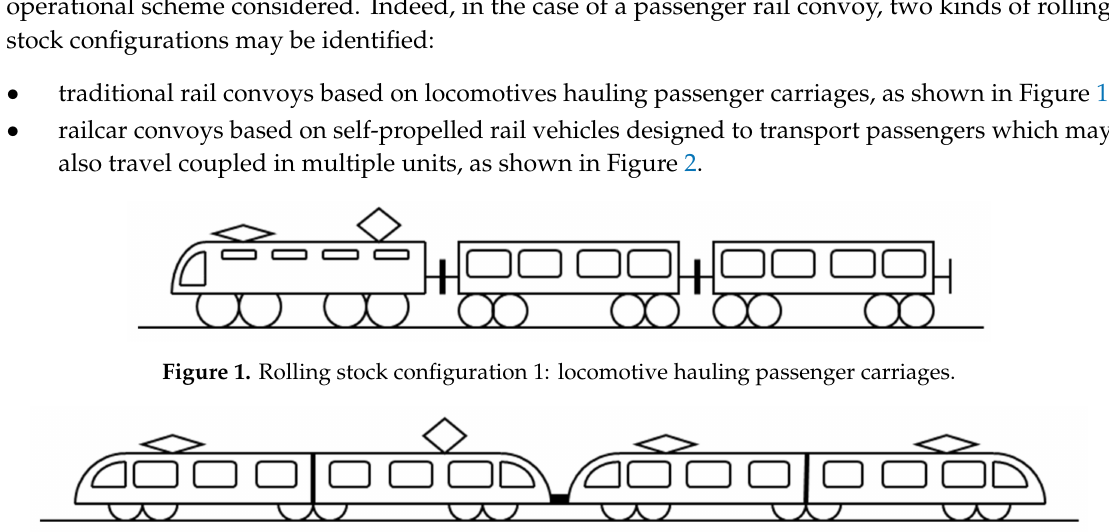
Figure 2. Rolling stock configuration 2: railcars coupled in multiple